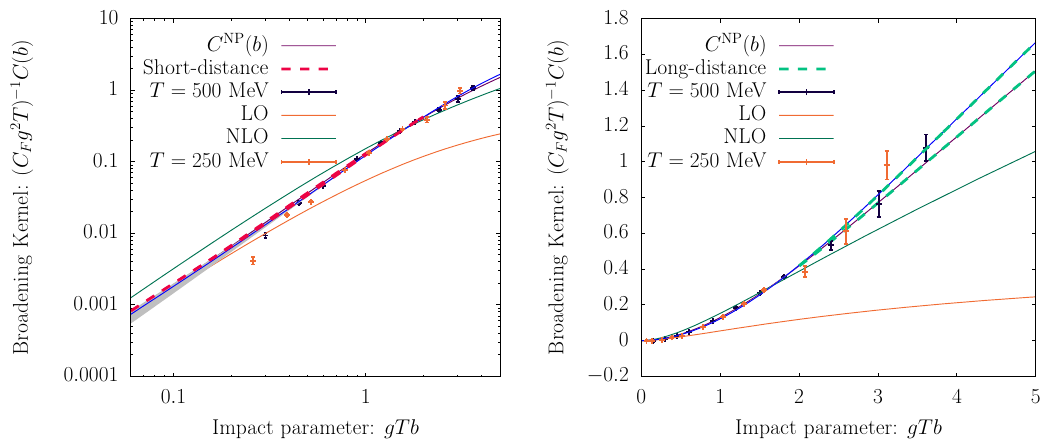
Figure 2. Non-perturbative elastic broadening kernel interpolation spline in the short-distance (left) and large-distance (right) regimes. We compare to both the short-distance limit from eq. (2.8) and the long-distance limit from eq.